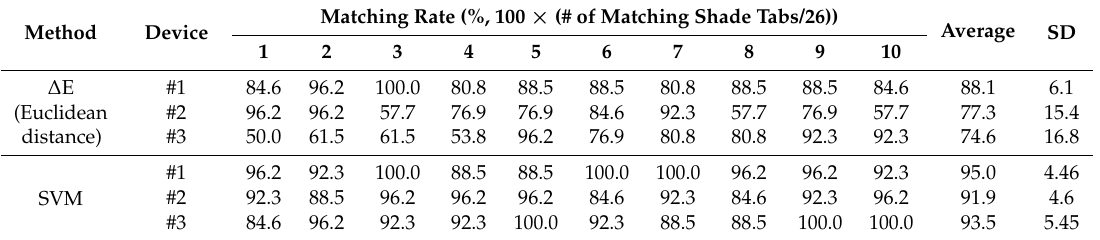
Table 1. Accuracy of the developed digital shade-matching device using the Euclidean distance and the support vector machine (SVM) algorithm.